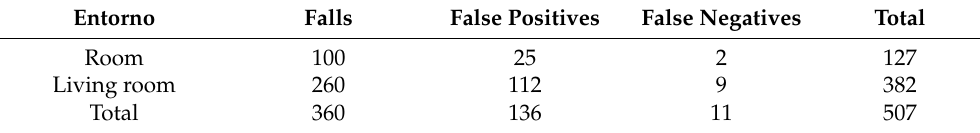
Table 4. Frequency table of the results obtained from the System observed in two